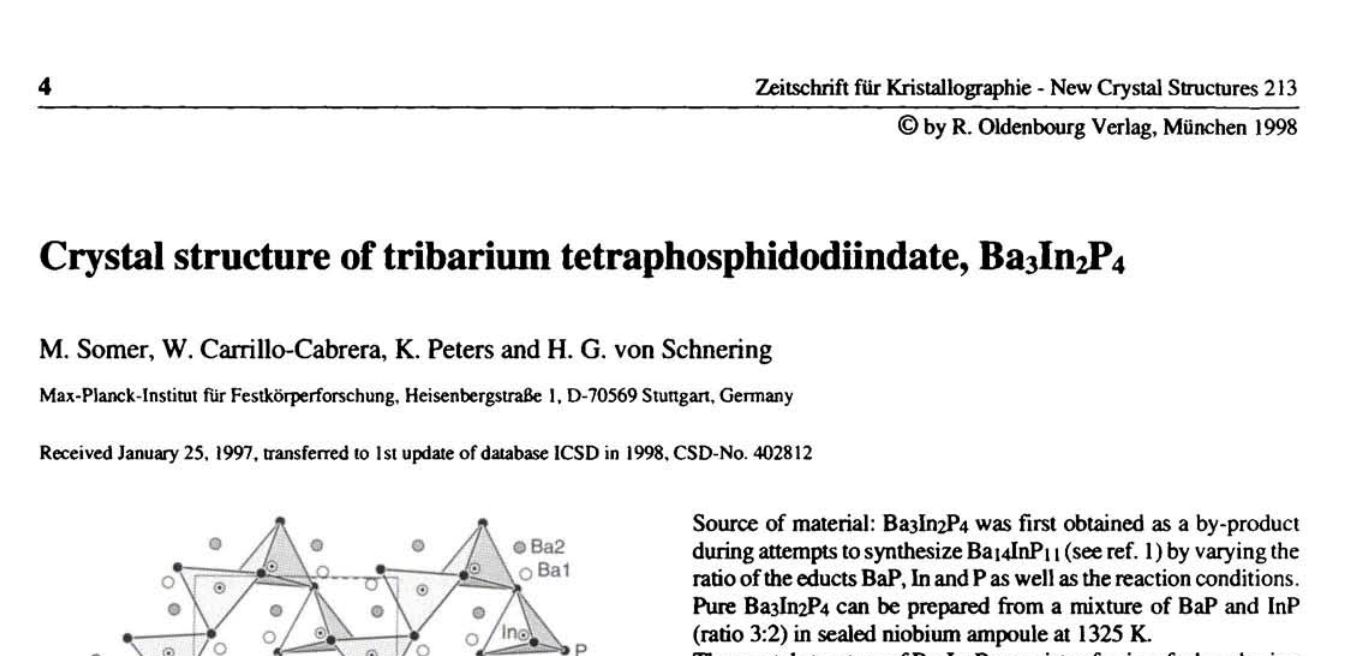
Table 1. Parameters used for the X-ray data collection